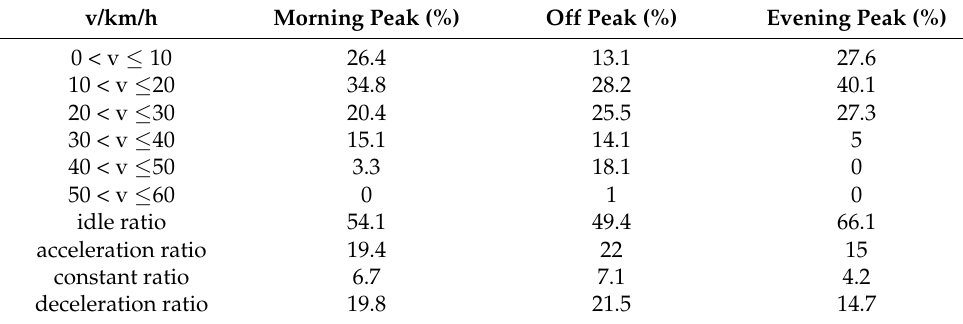
Table 2. Driving condition distribution of business district for peak hour.